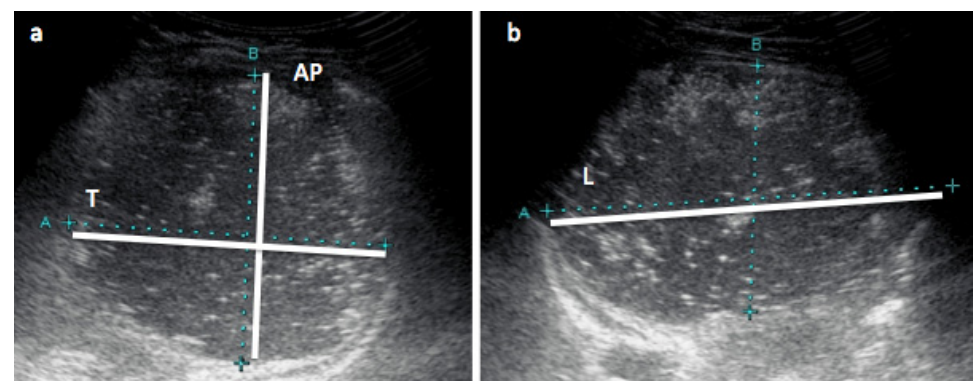
Figure 1. Measurements of infant’s stomach with ultrasound. Ultrasound images of infant’s stomach: ( a ) transverse view with anterior ‐ posterior (AP) and transverse (T) diameter measurements; ( b ) longitudinal view with longitudinal (L) diameter (maximum length) measurement. Stomach volume (mL) = longitudinal diameter (mm) × anterior ‐ posterior diameter (mm) × transverse diameter (mm) × 0.52.